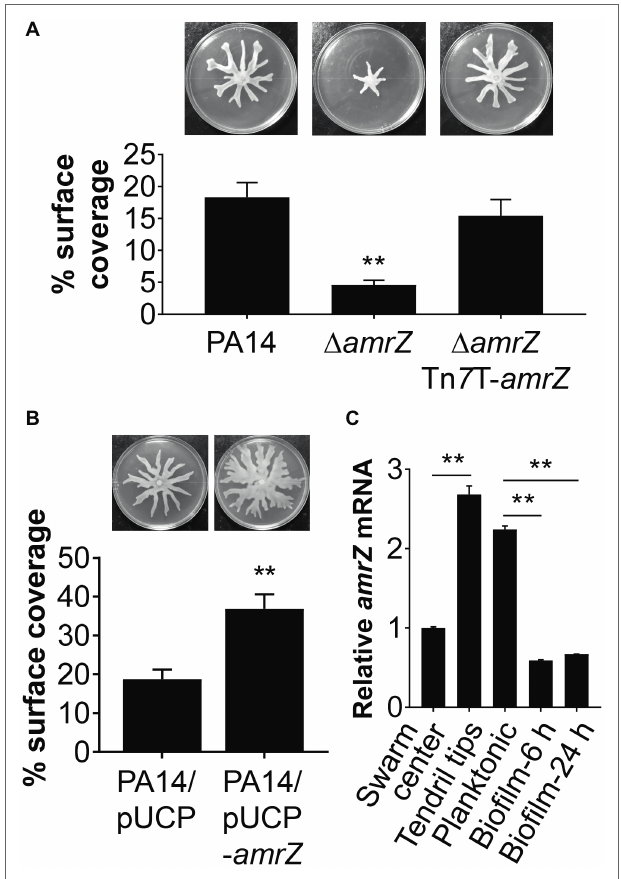
FIGURE 1 | AmrZ plays a role in the regulation of swarming motility in P. aeruginosa PA14. (A) Swarming motility and average percentage of the surface coverage of WT PA14, the ∆ amrZ mutant, and the single-copy complemented strain of the ∆ amrZ mutant carrying an amrZ gene inserted into chromosome by mini-Tn 7 T. Error bars represent the standard deviations. ** p < 0.01 compared with WT or complemented strains by Student’s t -test. (B) Swarm analysis and quantification of percent coverage of swarm plates for the WT strain carrying vector control (PA14/pUCP) or a multicopy amrZ -containing plasmid (PA14/pUCP- amrZ ). (C) RT-qPCR analysis of amrZ mRNA levels in WT PA14 from actively swarming tendril tips, cells localized in the center of swarming colonies, free-swimming planktonic cells, and cells grown as biofilm at 6 h (initial attachment) and 24 h (developed biofilm). The relative gene expression was reported relative to the levels in swarm center cells. Significance was determined by Students’ t -test (** p <